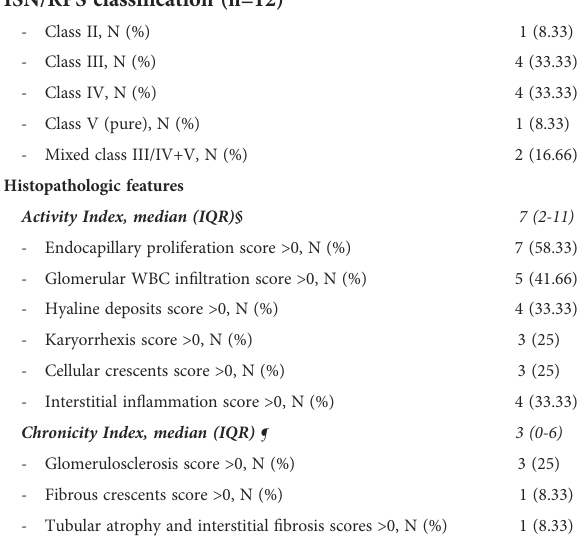
TABLE 2 Histopathologic features of the active lupus nephritis